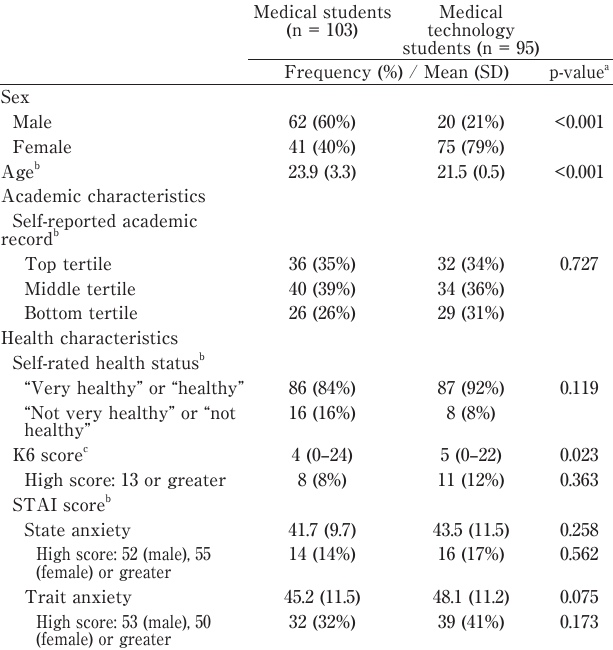
Table 1. Characteristics of the subjects (n =